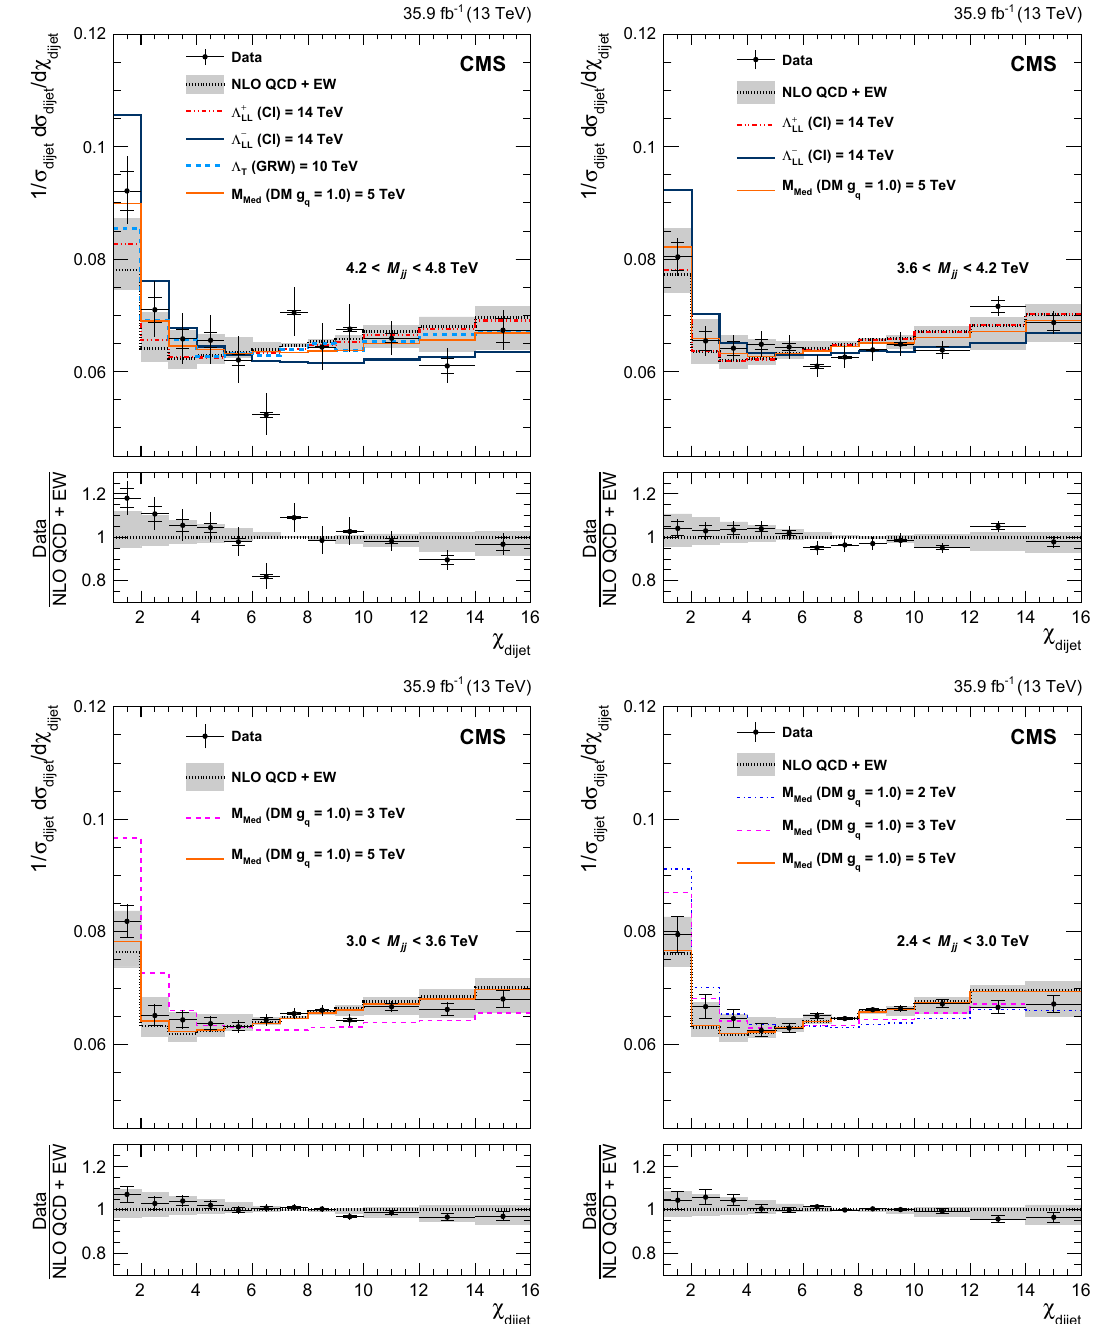
Fig. 2 Normalized χ dijet distributions in the four lower mass bins. Unfolded data are compared to NLO predictions (black dotted line). The error bars represent statistical and experimental systematic uncer- tainties combined in quadrature. The ticks on the error bars correspond